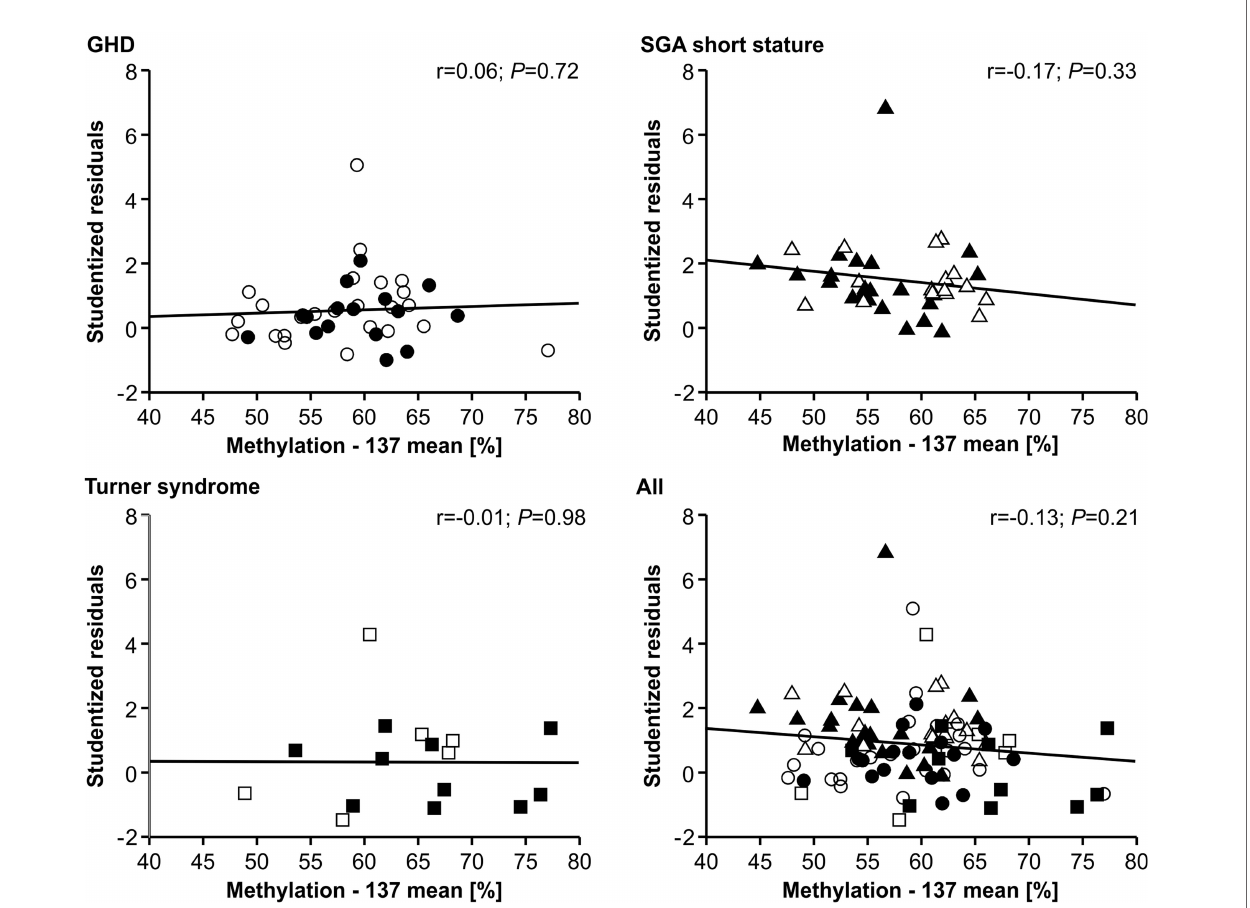
FIGURE 3 | Studentized residuals of fi rst year height prediction and IGF1 P2 methylation at position -137 in blood of children with GHD, SGA short stature and Turner syndrome treated with rhGH. Filled symbols indicate patients with exon3-deleted GHR